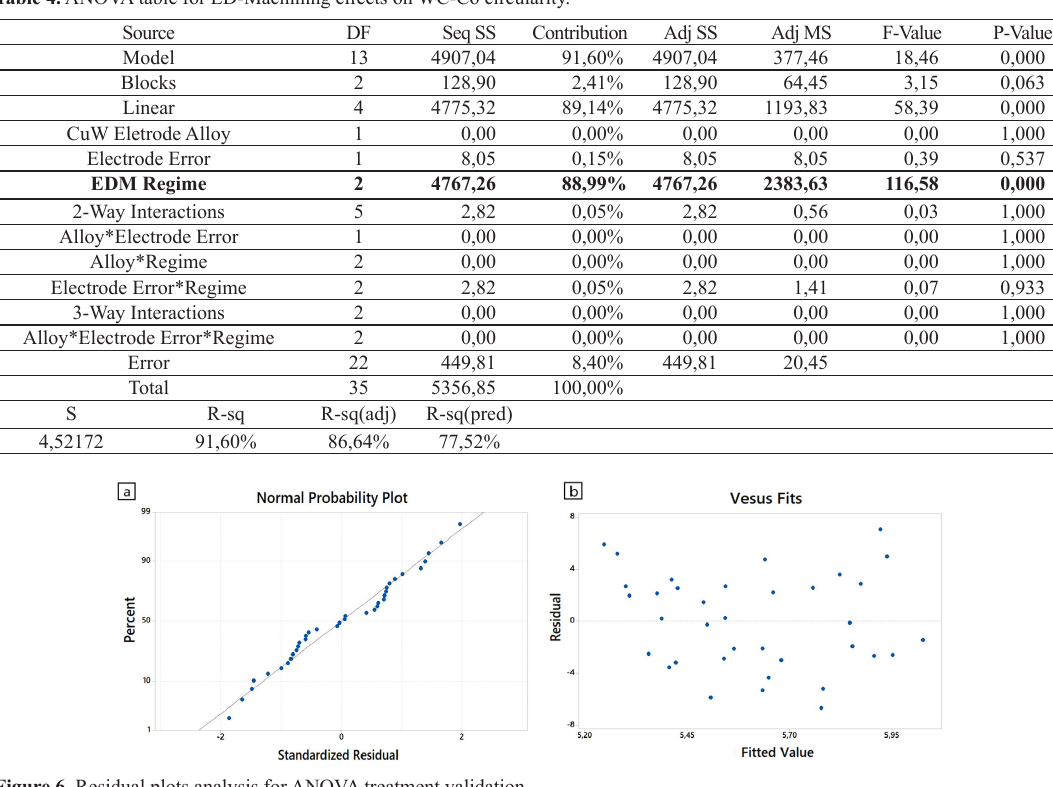
Figure 6. Residual plots analysis for ANOVA treatment validation.